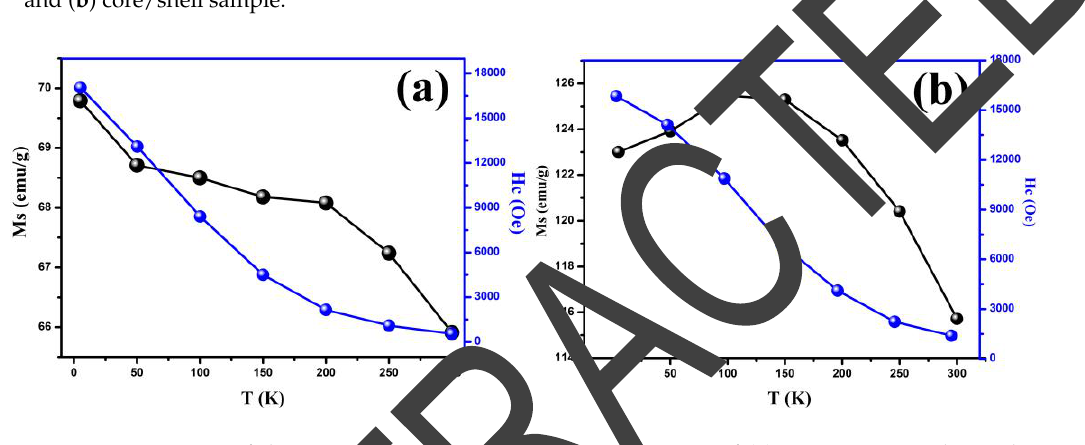
Figure 6. Variation of the coercivity and saturation magnetization of ( a ) core nanoparticles with temperature and ( b ) core/shell nanoparticles with temperature.